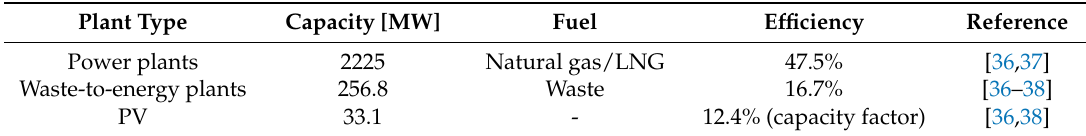
Table 1. The energy supply of Singapore in the reference